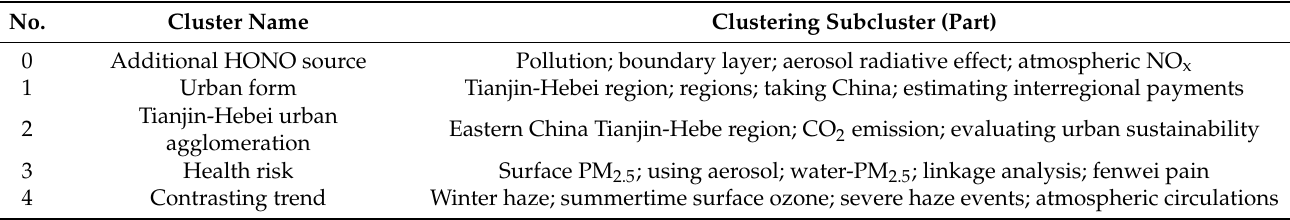
Table 1. Keyword cluster